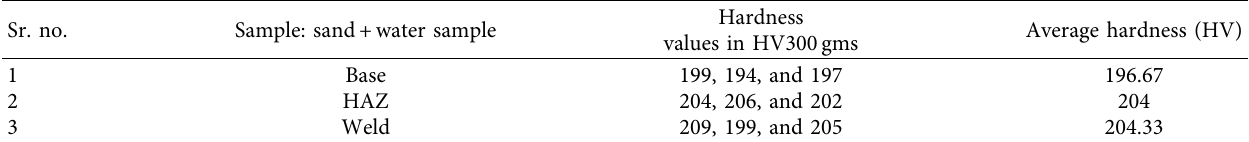
Table 5: Microhardness values in sample 5 (stepped cooling sand +water). Sr.